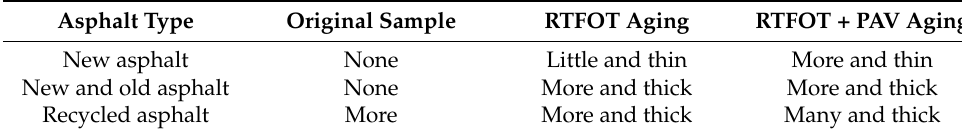
Table 3. Cracks of three asphalt samples before and after aging. Asphalt